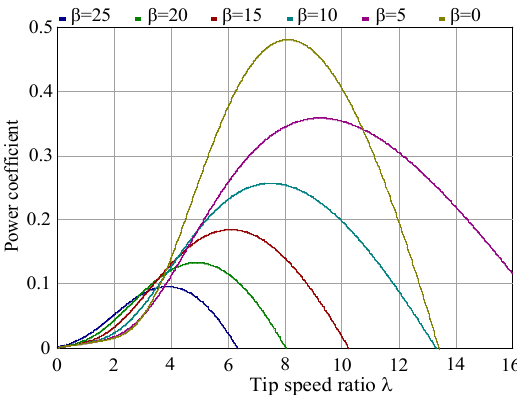
Figure 4. Power coefficient ‐ tip speed ratio ( C p ‐ λ ) curves for different blade angles.